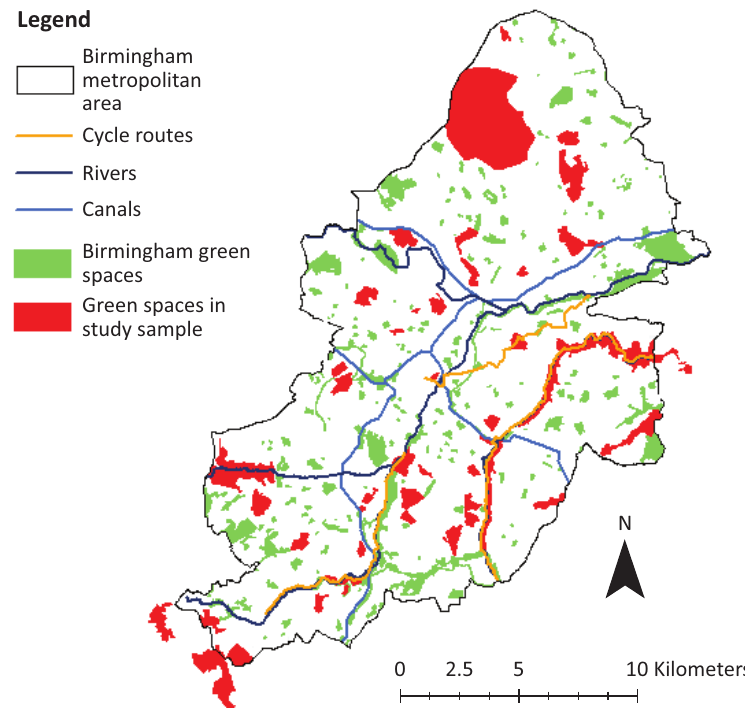
Figure 1. The locations of the green space study sites included in this article.